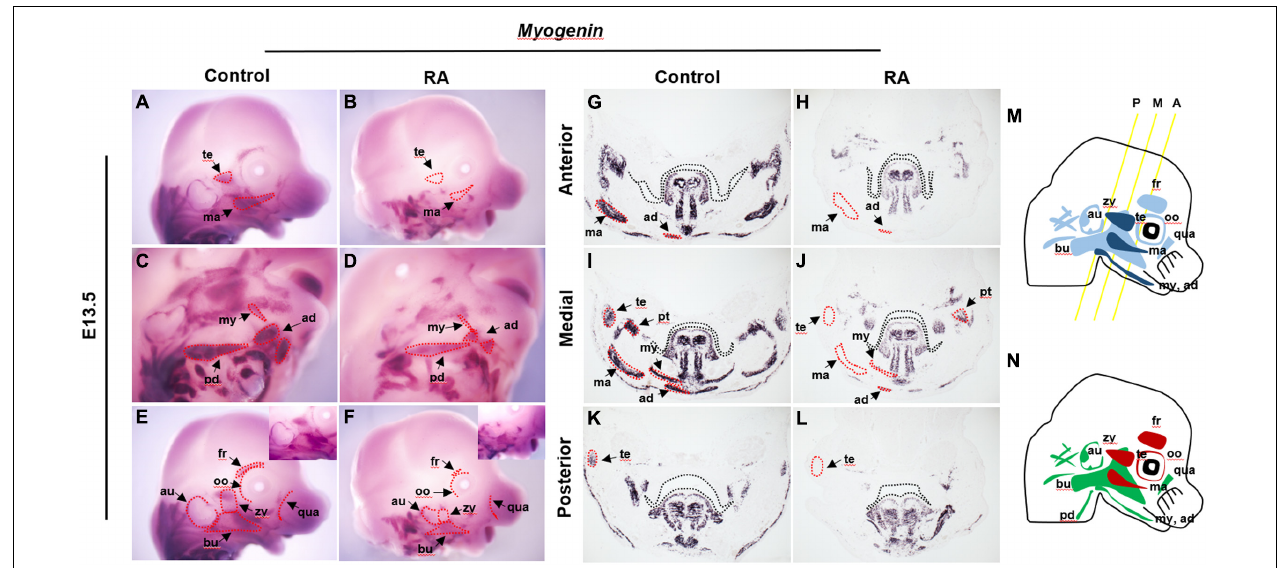
FIGURE 1 | Abnormalities of BA1 and BA2 derived muscles in RA-treated embryos. Myogenin in situ hybridization for whole-mount (A–F) and frontal sections from anterior (G,H) , medial (I,J) , and posterior (K,L) regions (see M for approximate levels of sections along the anterior-posterior axis) of E13.5 control (A,C,E,G,I,K) and RA-treated (B,D,F,H,J,L) embryos. In (G–L) black dashed lines indicate the margin of palatal shelf and tongue primordium. In RA-treated embryos, the BA1-derived temporalis (te) and masseter (ma) muscles are absent (marked by red dashed lines in B,H,J,L ); pterygoid (pt), mylohyoid (my) and anterior digastric (ad) muscles are reduced to small components (compare in D,H,J,L to C,G,I,K ). (C–F) The RA-treated BA2-derived muscles are either absent (red dashed line) or replaced by a few muscle fibers. Higher magnifications are shown in upper right boxes of (E,F) . (M,N) Schematics of BA1- and BA2-derived muscles. (M) Dark blue indicates muscles of BA1 origin; light blue indicates muscles of BA2 origin. Yellow lines illustrate the levels of frontal sections shown in (G–L) . A, anterior; M, medial; P, posterior. (N) Red indicates absent in RA-treated embryos; green indicates reduced in RA-treated embryos. ad, anterior digastric muscle; au, auricularis muscle; bu, buccinators muscle; ma, masseter muscle; my, mylohyoid muscle; oo, orbicularis oculi muscle; pd, posterior digastric muscle; pt, pterygoid muscle; qua, quadratus labii muscle; te, temporalis muscle; zy, zygomaticus